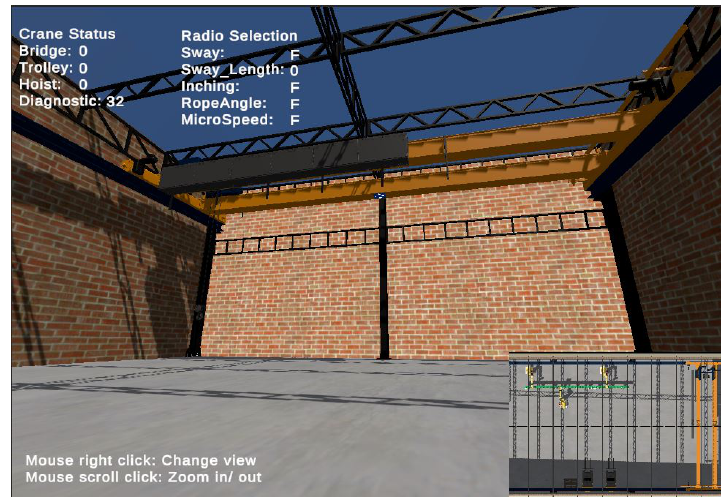
Figure 10. The screenshot of the remote monitor prototyping app. The dashboard is located in the upper left corner with operating data. Moreover, mouse control and screen touch can implement the view change.